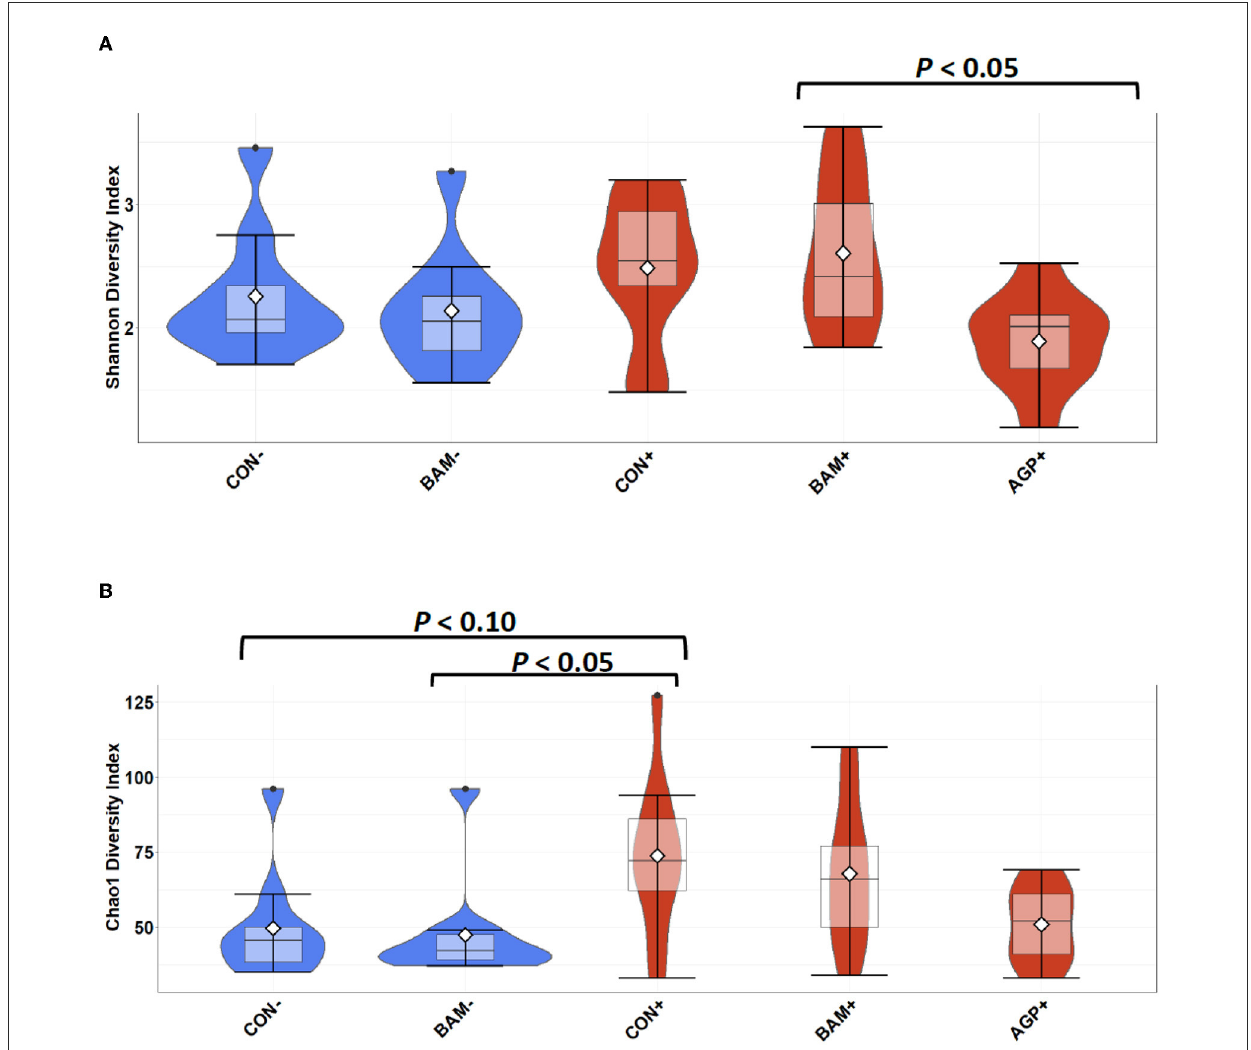
FIGURE6 Alpha diversity as indicated by Shannon (A) and Chao1 (B) indices in ileal digesta collected from weaned pigs fed with a control (CON) diet or diets supplemented with Bacillus amyloliquefaciens (BAM) or antibiotics (AGP) 21 days after enterotoxigenic E. coli (ETEC) inoculation. Violin plots are colored by ETEC infected or not. Data are expressed as mean (diamond) ±